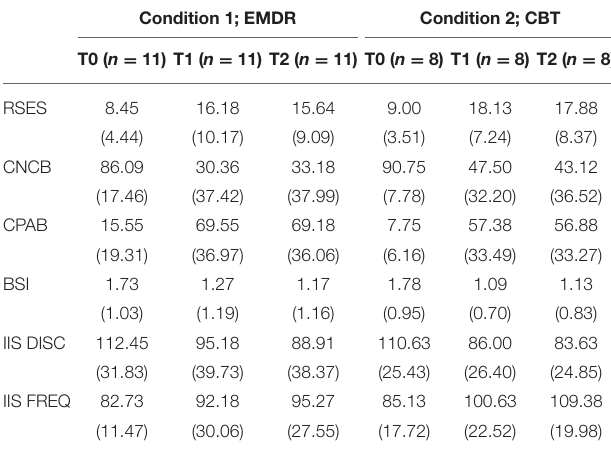
TABLE 2 | Means (SD) of the outcome